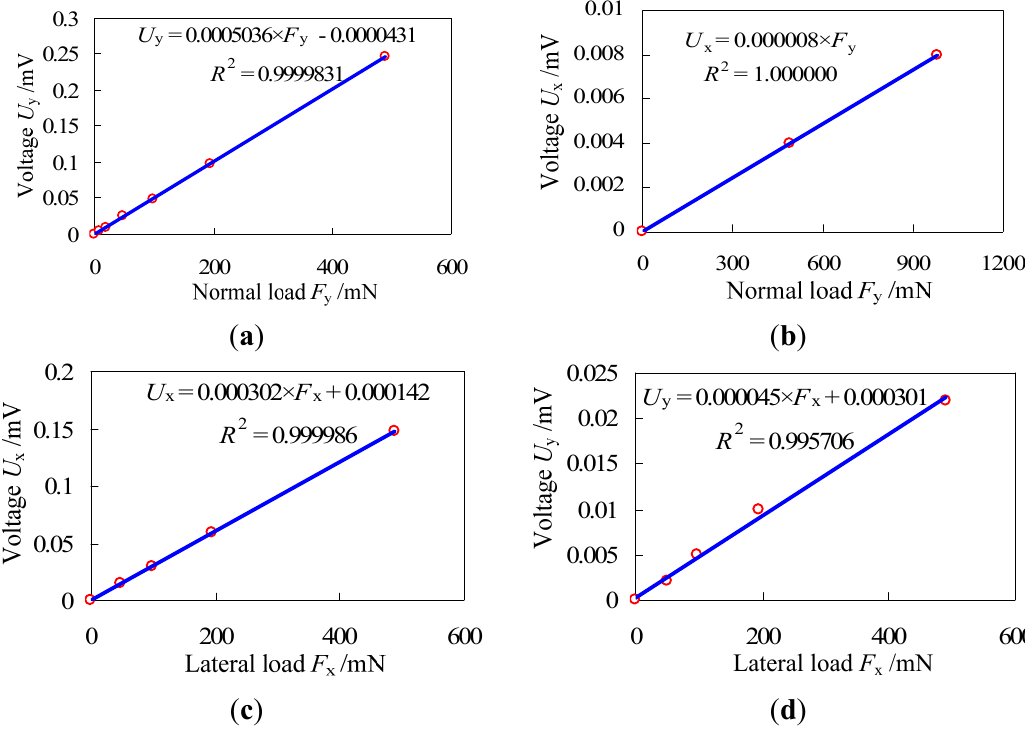
Figure 9. Calibration curves of the two-axis load sensor. ( a ) is the relationship between the and the output voltage U from the strain gauges on the middle of the normal load F y y elastic body; ( b ) is the relationship between the normal load F and the output voltage U y x from the strain gauges on the two sides of the elastic body; ( c ) is the relationship between and the output voltage U from the strain gauges on the two sides of the the lateral load F x x elastic body; ( d ) is the relationship between the lateral load F and the output voltage U x y from the strain gauges on the middle of the elastic body. U y = 0.0005036× F y - 0.0000431 R 2 =